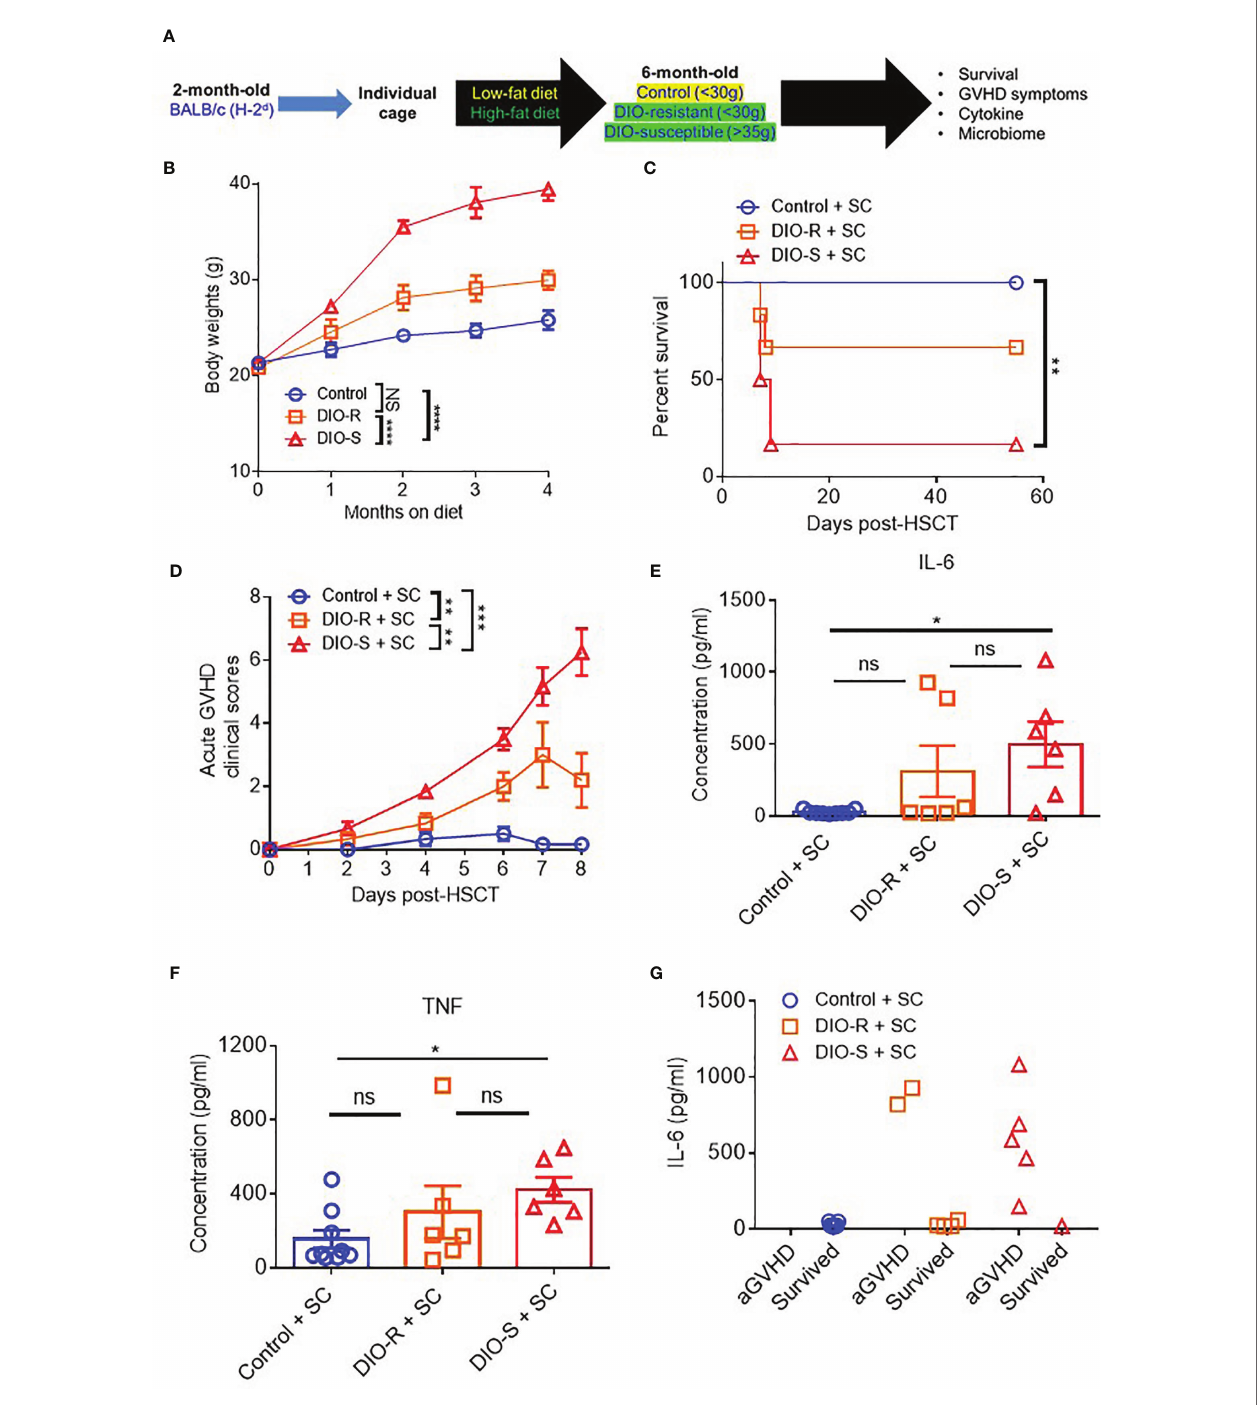
FIGURE 4 | (A) 8-week-old BALB/c mice were individually housed and put on LF or HF diet for 4 months. Mice were then lethally irradiated and received 8 million bone marrow cells and 25 million splenocytes from donor B10.D2 mice. (B) Kinetics of body weight gain of BALB/c mice on LF or HF diet. (C) Survival rate post- HSCT (n=6-9/group). (D) aGVHD clinical scores post-HSCT (n=6-9/group). (E) Serum IL-6 and (F) TNF concentrations at day 7 post-HSCT (n=6-9/group). (G) Correlation between acute GVHD outcomes and IL-6 levels (n=6-9/group). Bar graphs depict mean ±s.e.m. Survival curve (C) was plotted on a Kaplan-Meier curve and analyzed by a log-rank test. Body weght curve (B) and clinical scores (D) were analyzed by 2-way analysis of variance (ANOVA) with Tukey's post hoc test for comparison among groups. One-way ANOVA test was used in (E, F) . *p < 0.05, **p < 0.01, ***p < 0.001, NS, not signi fi